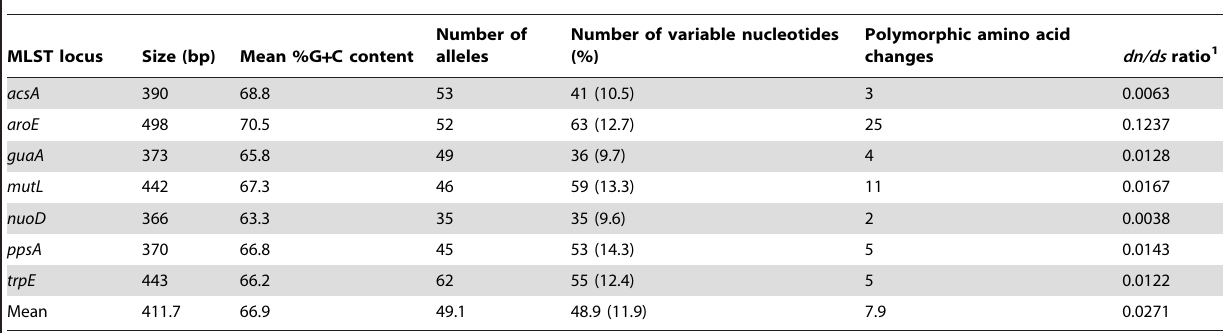
Table 1. Genetic diversity and evolutionary parameters of the 272 Pseudomonas aeruginosa sequence types.